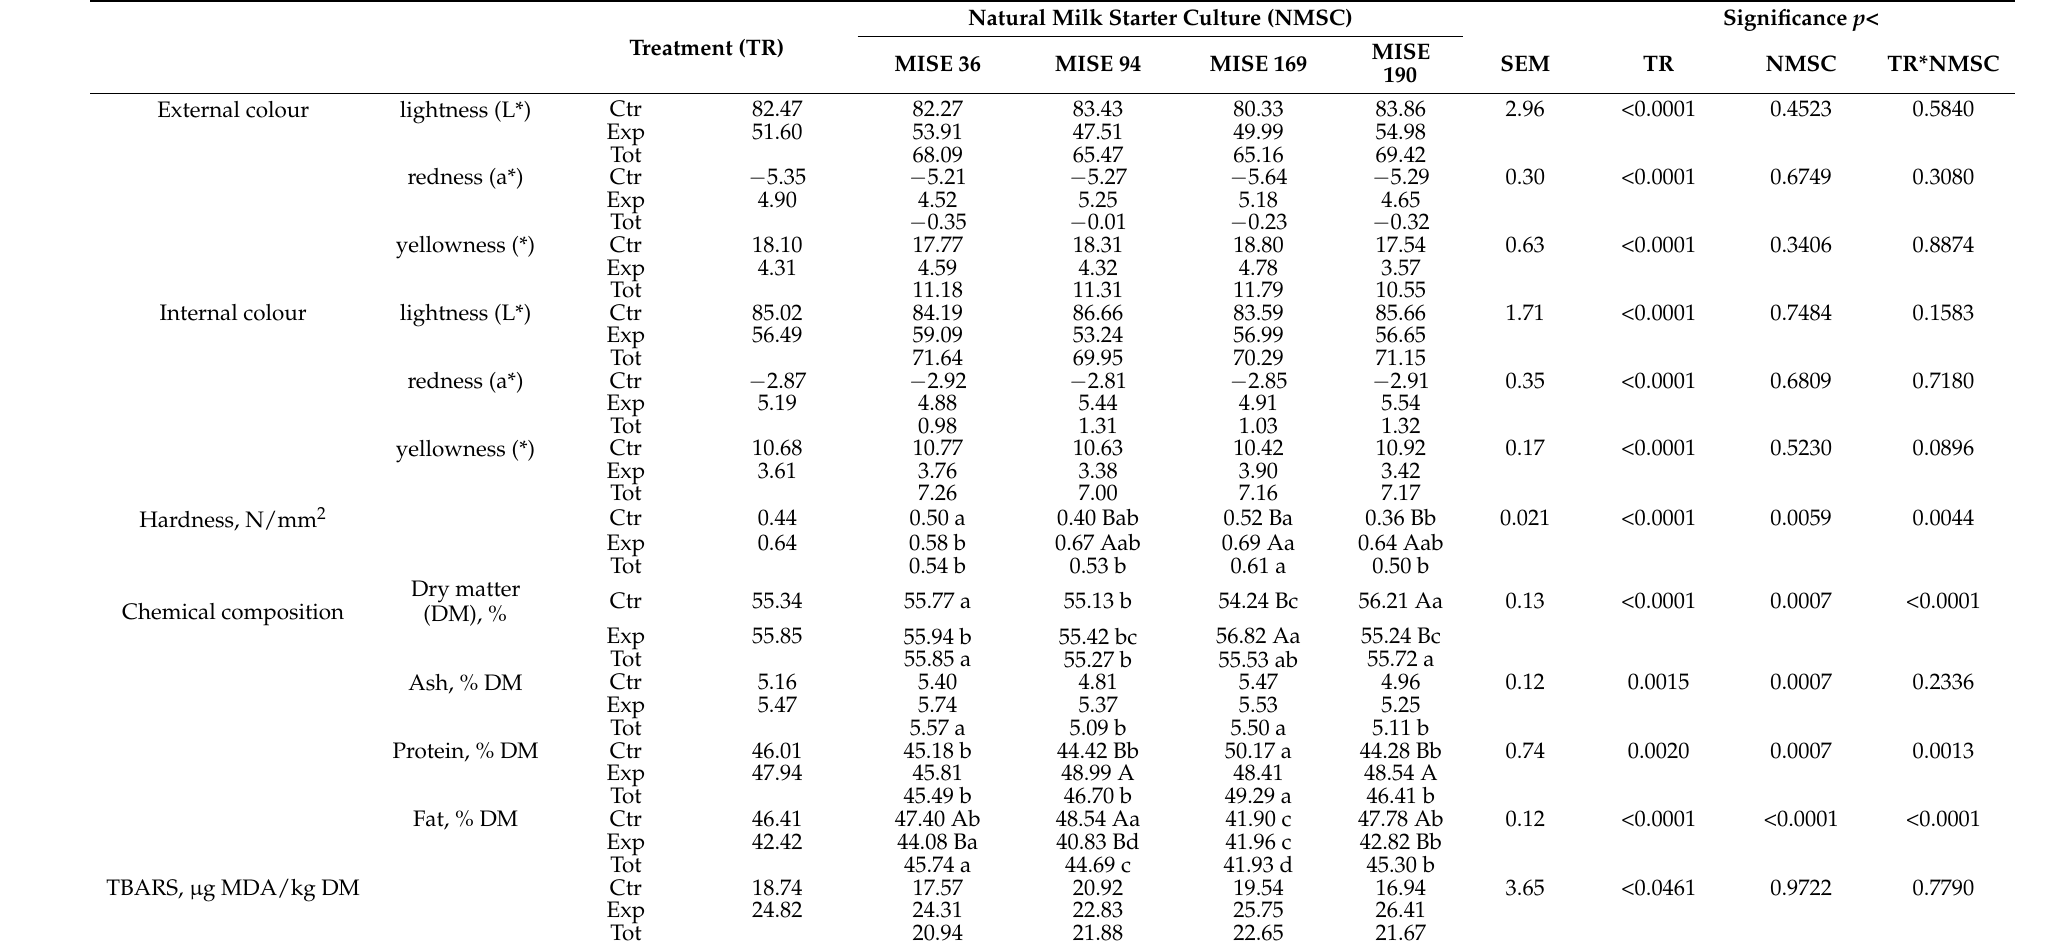
Table 3. Physicochemical traits of cheeses after 15 d of refrigerated